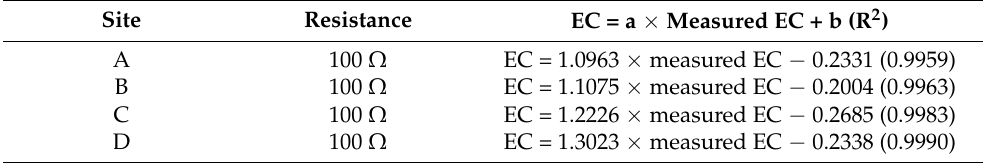
Table 2. The resistance setup and calibration curves for the deployed sensors in the